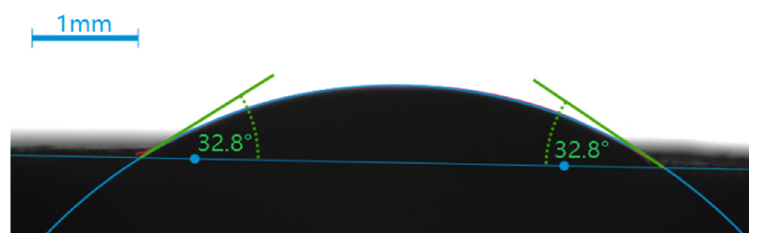
Figure 3. Contact angle of carbon dust.